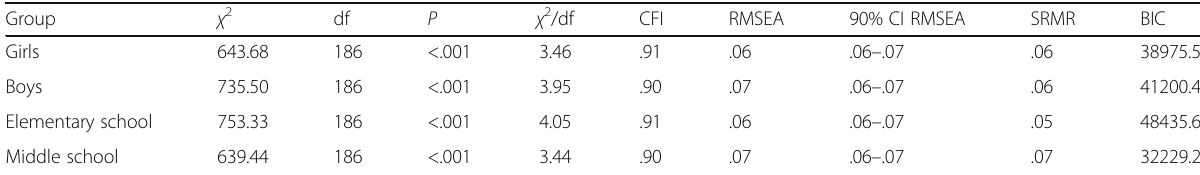
Table 2 Model fit for the three-factor model by gender and educational level Group χ 2